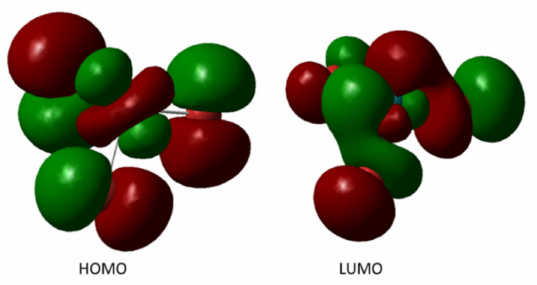
Figure 3. The HOMO and LUMO orbital for RhBr 3 complex.